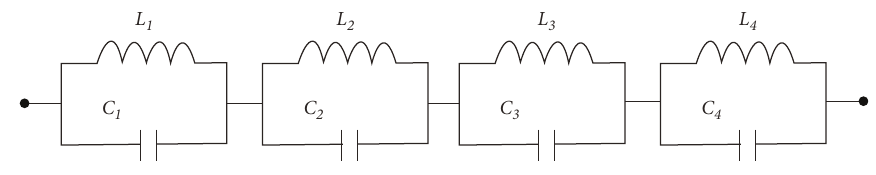
Figure 4: Equivalent LC circuit model of the designed